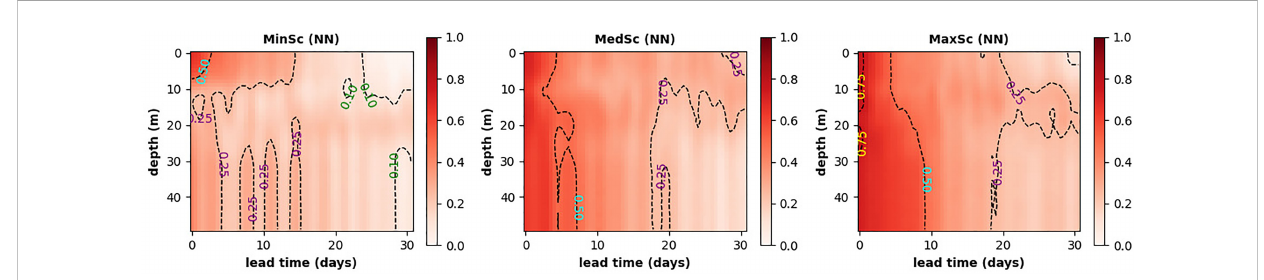
FIGURE 9 The MLP NN model forecast skill measured by the Pearson correlation shown for the full range of depths at L4 (y-axis) vs the forecast lead time (on the x- axis). The three panels are the three scenarios explored in this study: using only surface chlorophyll and temperature data (MinSC, left-hand panel), using also sub-surface temperature data (MedSC, middle panel) and using both temperature and chlorophyll sub-surface data (MaxSC, right-hand